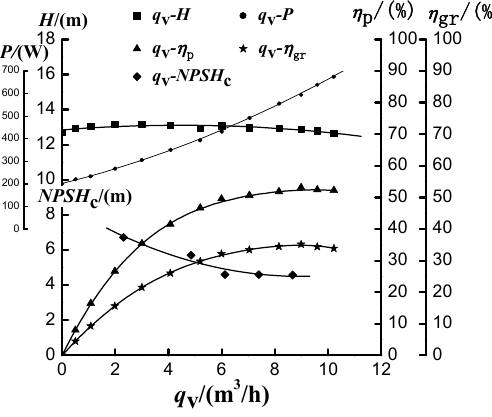
Figure 3. Experimental pump performance curves.